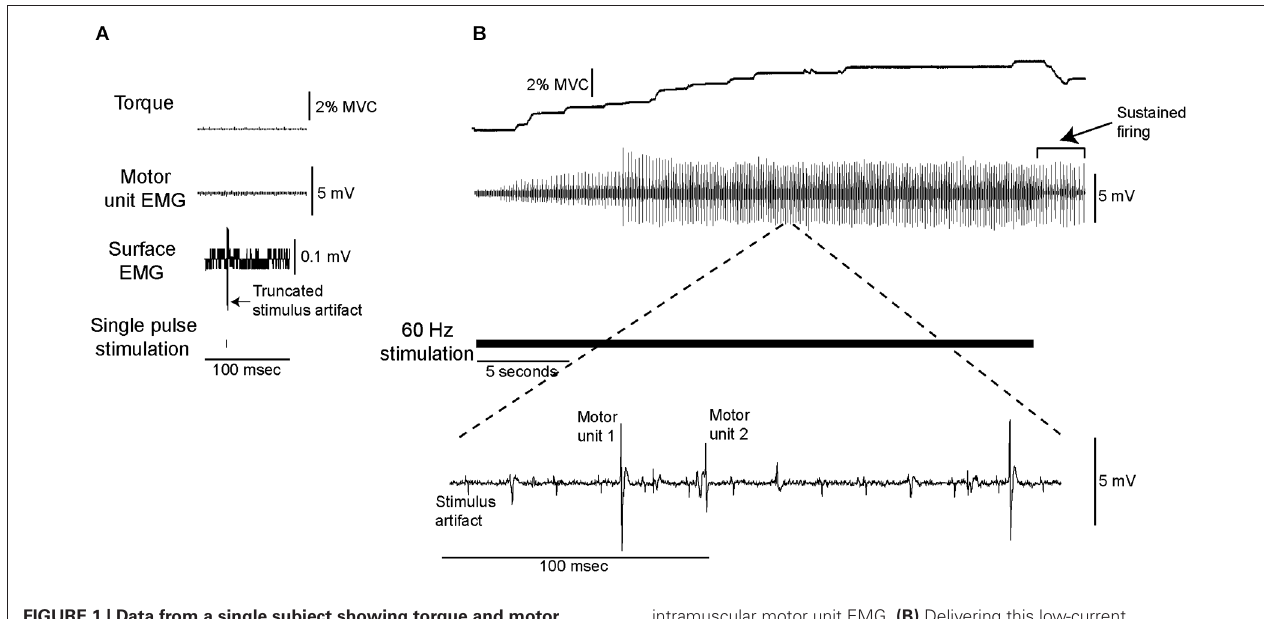
FIGURE 1 | Data from a single subject showing torque and motor unit activity evoked by low-current electrical stimulation. (A) The stimulation was delivered at a current at which a single pulse did not elicit any measurable change in ankle extensor torque, surface or